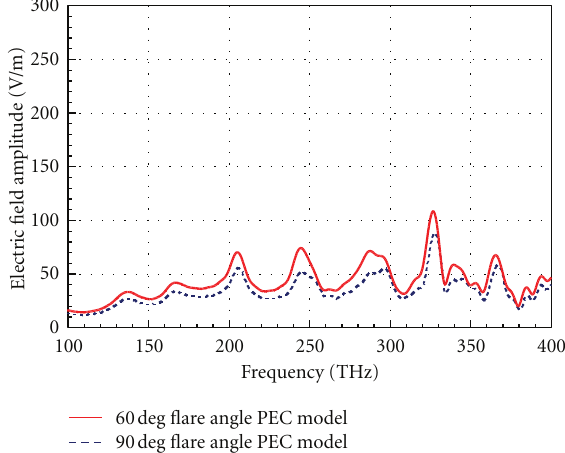
Figure 7: Electric field at the feed gap location of single bowtie for PEC model of gold.